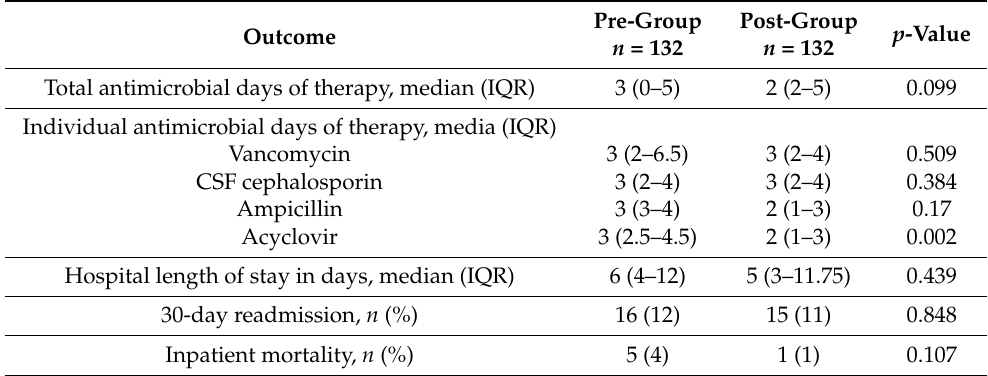
Table 4. Primary and Secondary Outcomes compared between included patients in the Pre- and